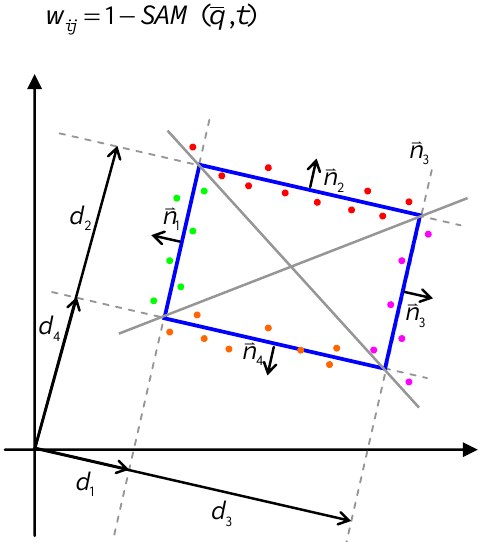
Figure 1: Four lines (gray dashed lines) defined with vector pairs ( n , d ) forming a rectangle (blue). The diagonals of the rectangle (gray lines) define assignment of points to the